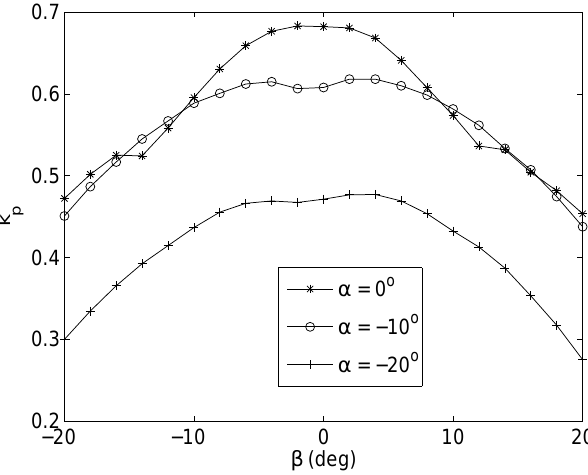
Fig. 8. Calibration coefficient k q for dynamic pressure against cali- bration angle β for three attack angles α . Fig. 7. Two dimensional plot of k β over k α . The figure shows the nonlinearities that are larger for higher airflow angles α and β .